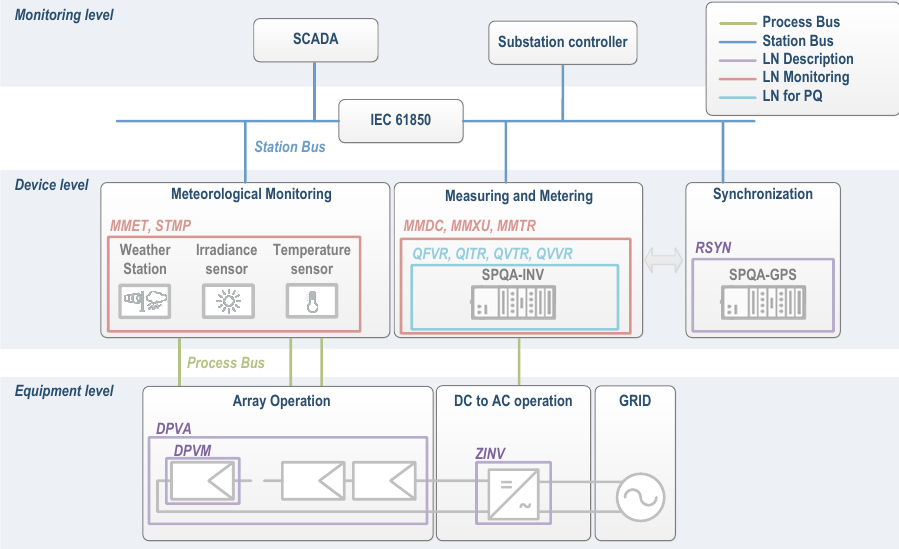
Figure 13. Overview of logical devices and logical nodes for distributed energy resource (DER) in the PV-on time system. DPVA: PV Array characteristics; DPVM: PV Module ratings; MMDC: DC Measurement; MMET: Meteorological Information; MMTR: Metering 3 Phase; MMXU: Measurement; QFVR: Frequency Variation; QITR: Current Transient; QVTR: Voltage Transient; QVVR: Voltage Variation; RSYN: Synchronism-check; SCADA: Supervisory Control And Data Acquisition; SPQA: Smart Power Quality Analyzer; ZINV: Inverter for converting direct current to alternating current (DC →